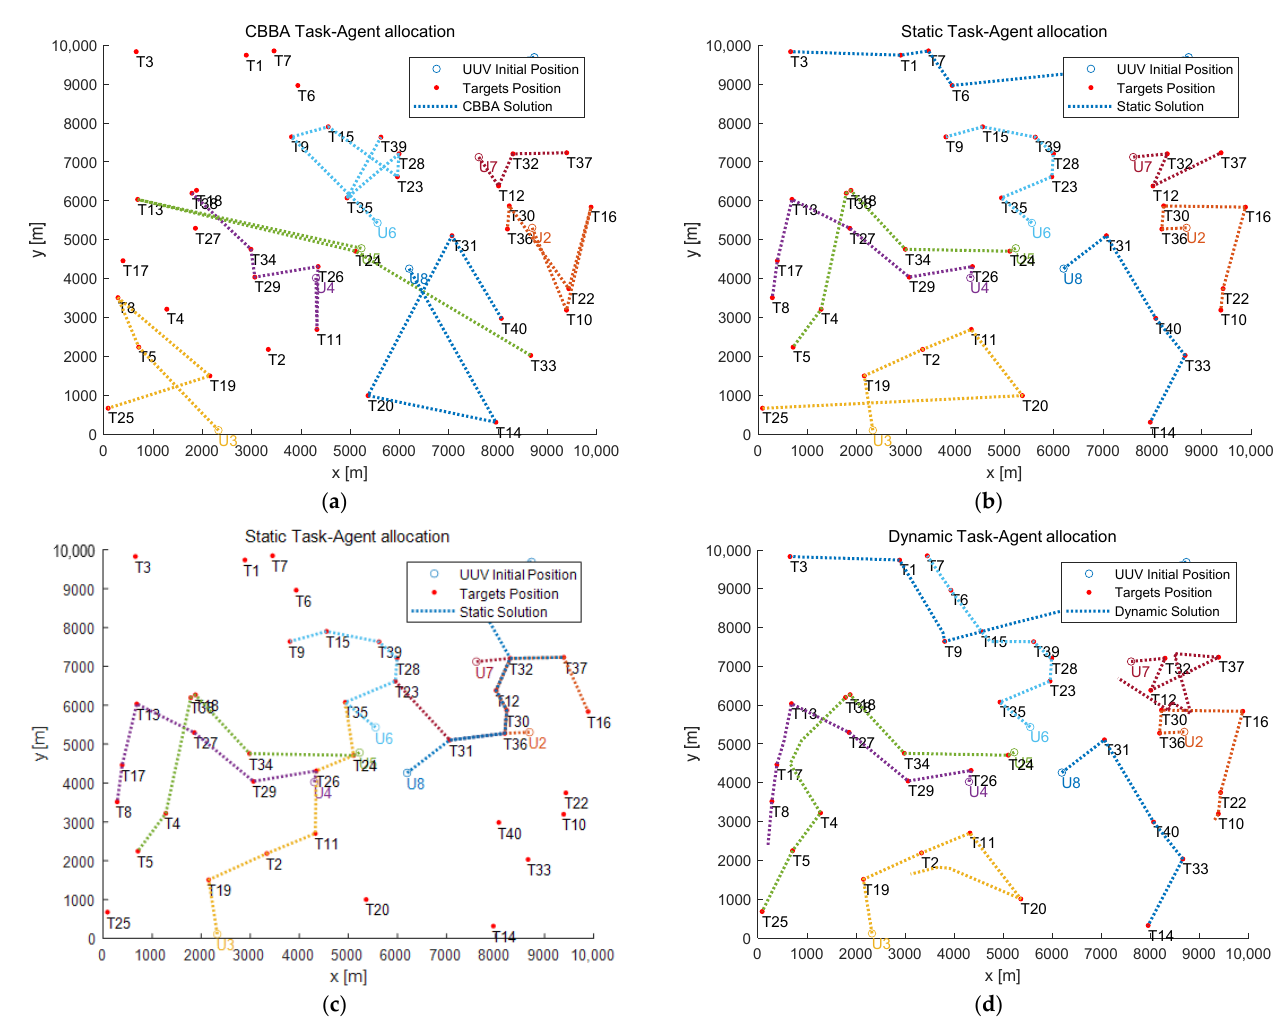
Figure 4. Task allocation profile. ( a ) Original CBBA (without communication range constraint). ( b ) ECBBA (without communication range constraint). ( c ) ECBBA (with communication range constraint). ( d ) DECBBA (with communication range constraint).